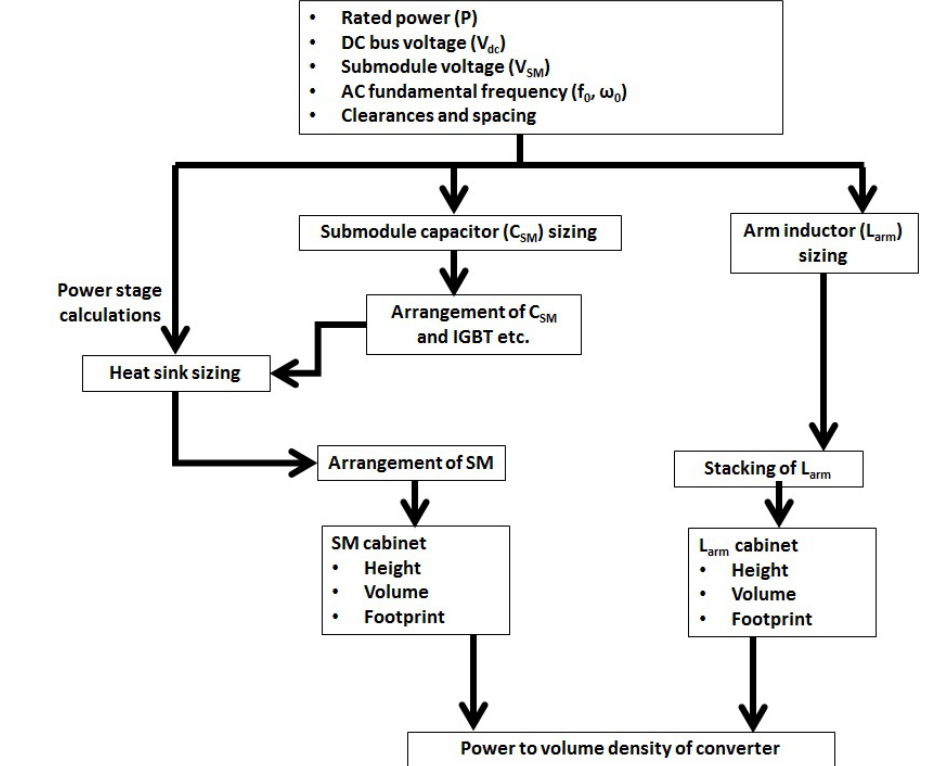
Figure 4. Simplified converter design algorithm for